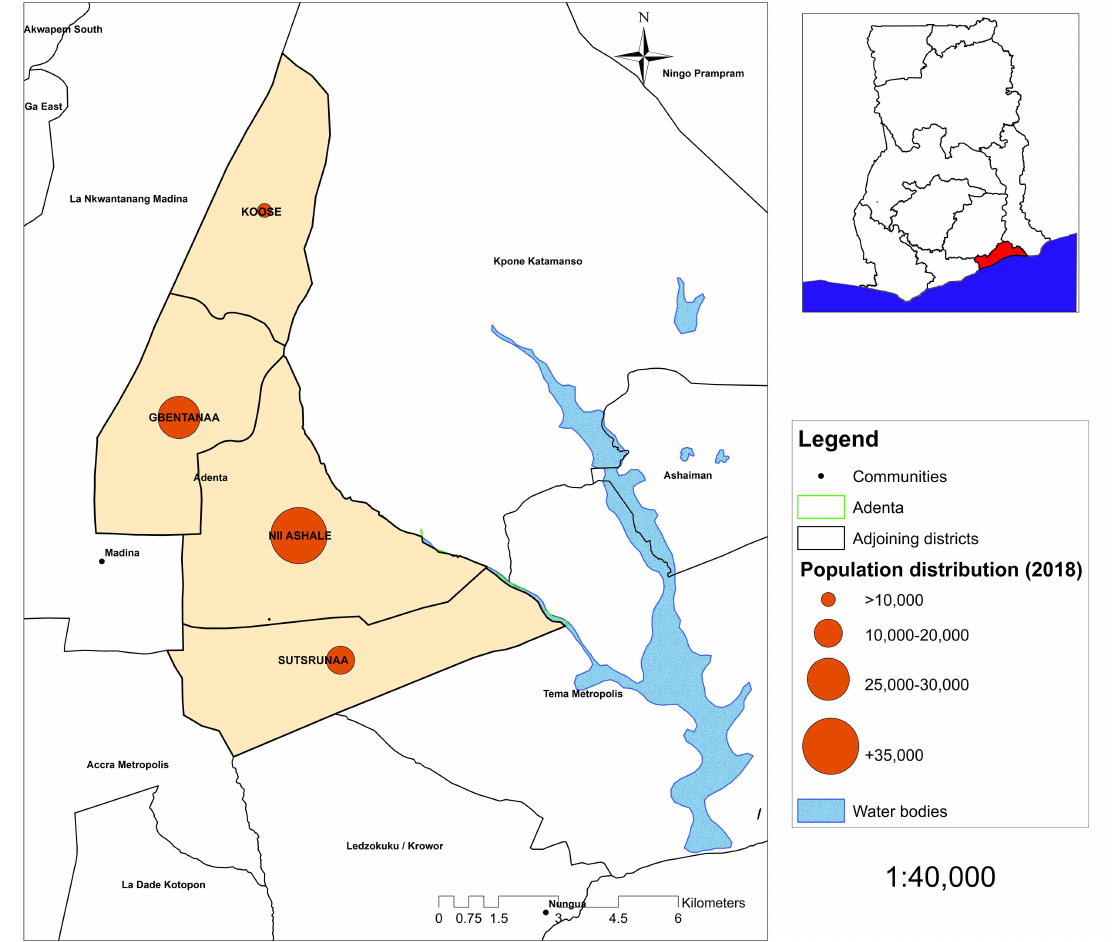
Figure 5. Population distribution of Adenta municipality in 2018 shown in zones (author’s